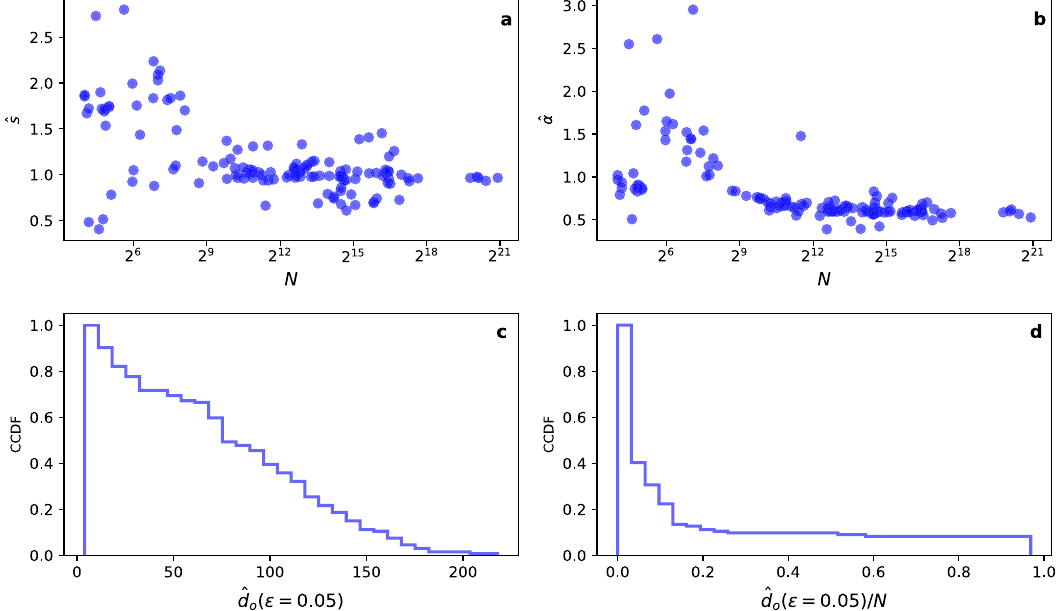
Fig. 3 Principled selection of the embedding dimension of real-world networks. a Distribution of ^ s over the corpus of 135 real-world networks considered in this paper. b Same as in panel a, but for ^ α . c Complementary cumulative distribution of ^ d o ð ϵ Þ , with ϵ = 0.05. d Complementary cumulative distribution of the best estimate ^ d o ð ϵ Þ rescaled by the network size N